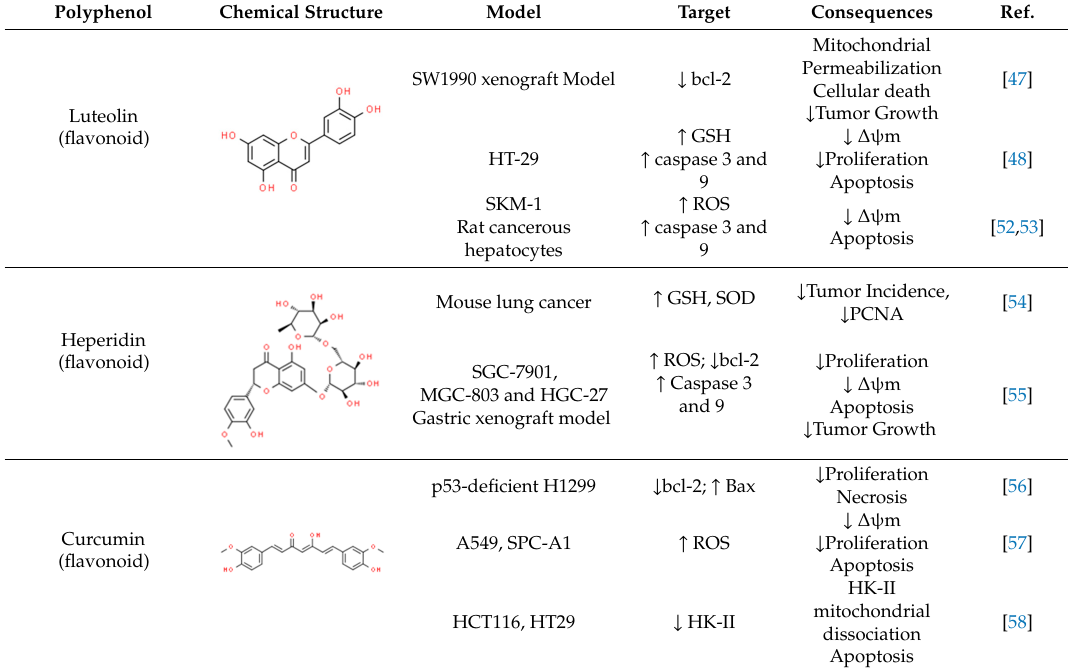
Table 1. Mitochondrial targets and e ff ects of polyphenols in cancer models. Table 1. Mitochondrial targets and effects of polyphenols in cancer models. Table 1. Mitochondrial targets and effects of polyphenols in cancer models. Table 1. Mitochondrial targets and effects of polyphenols in cancer